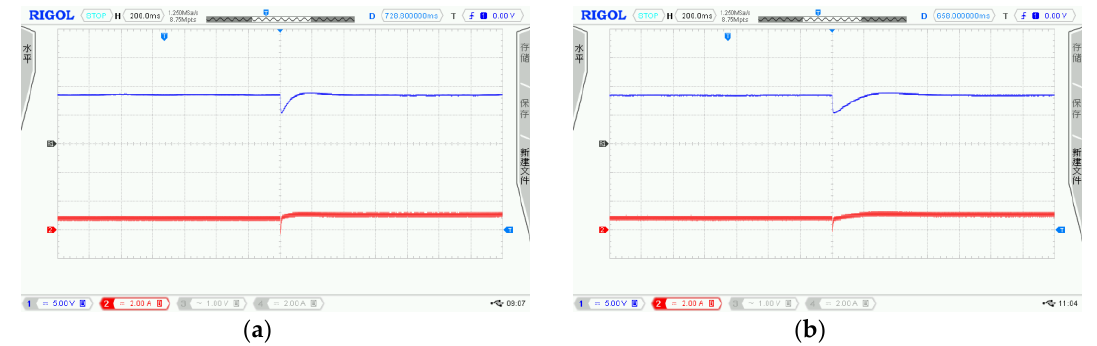
Figure 15. ( a ) LADRC controller: experimental comparison responses with Case 1; and ( b ) PI controller: experimental comparison responses with Case 1.